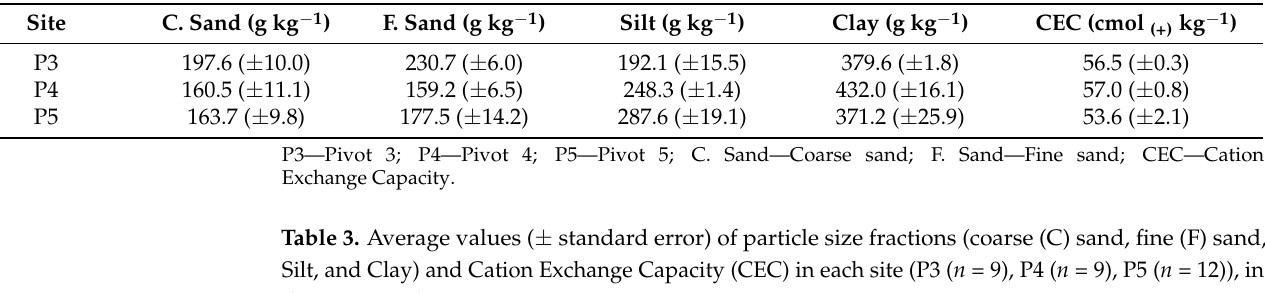
Table 2. Average values ( ± standard error) of particle size fractions (coarse (C) sand, fine (F) sand, Silt, and Clay) and Cation Exchange Capacity (CEC) in each site ((P3 ( n = 9), P4 ( n = 9), P5 ( n = 12)), in the 0–20 cm layer.